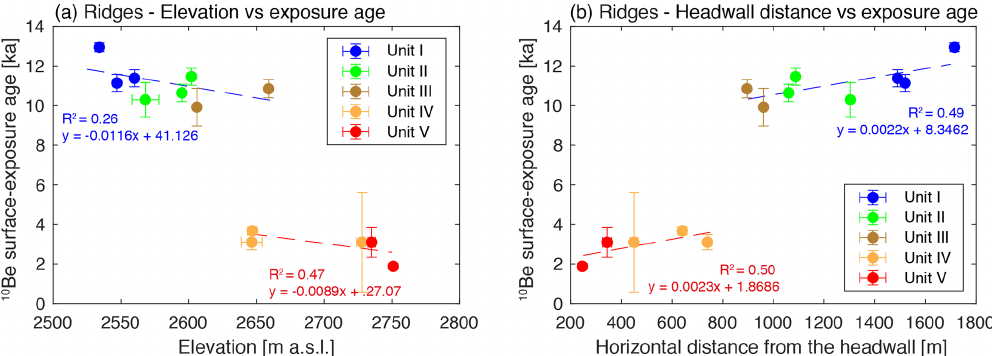
Figure A3. The 10 Be surface-exposure ages of individual ridges (a, b) plotted against elevation (a) and horizontal distance to the head- wall (b) . The dashed red and blue lines represent the linear regressions for cluster 1 (units I, II, and III) and 2 (units IV and V), respectively.